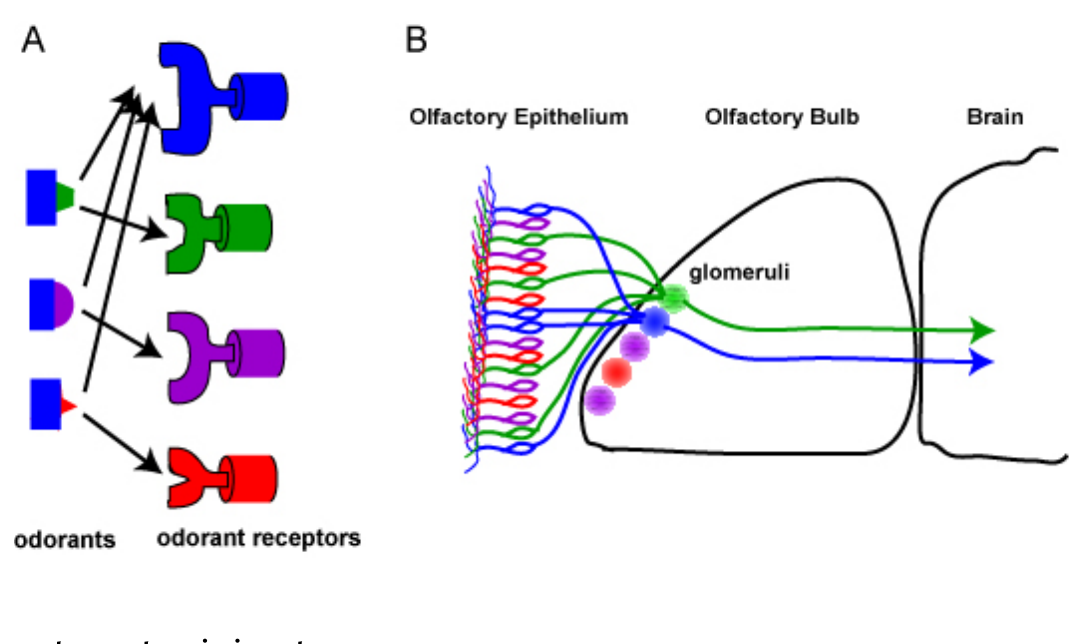
Figure 4. Combinational odorant receptor coding for